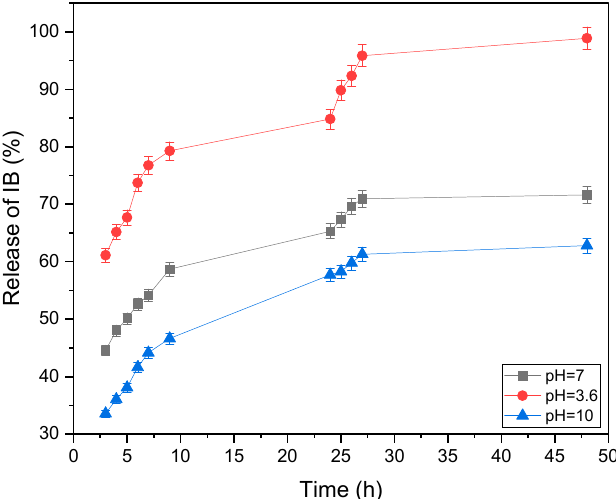
Figure 11. Evaluation of the release of IB at pH = 3.6, 7, and 10.